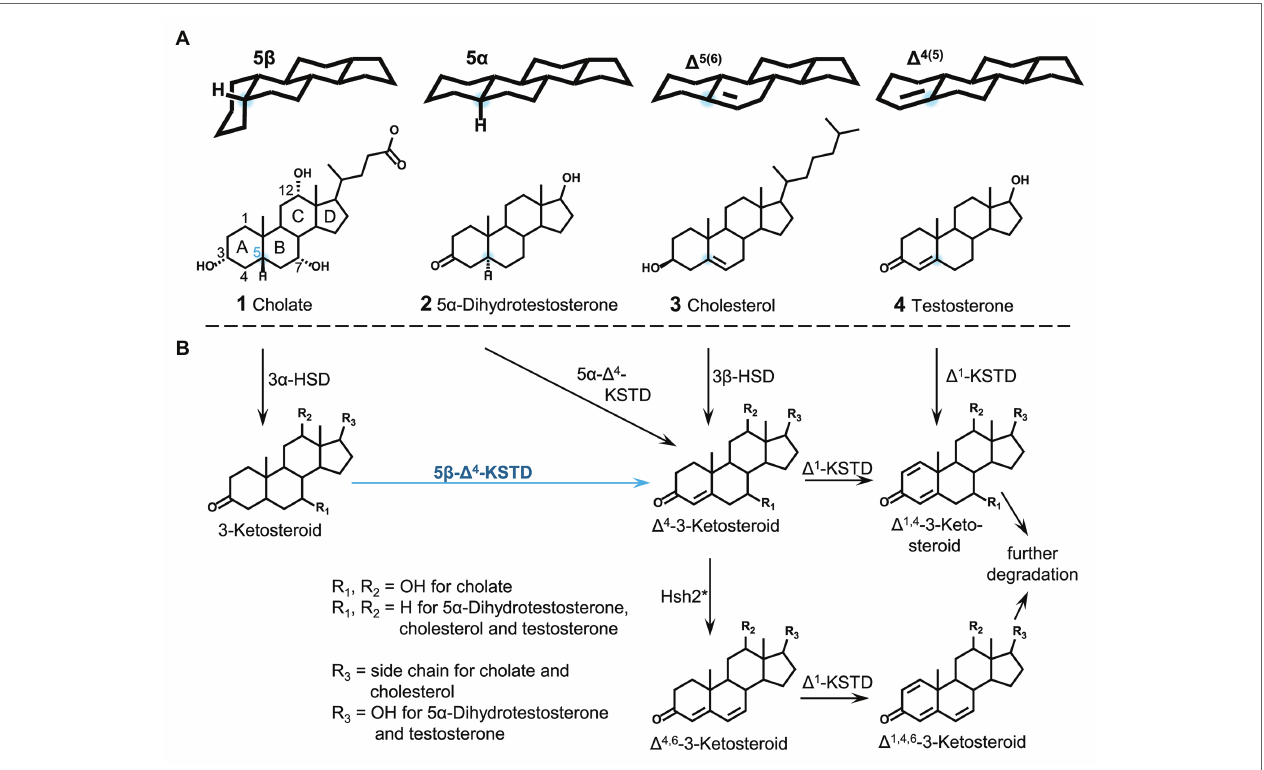
FIGURE 1 | Conformation and structures of steroids from different functional classes with varying stereochemistry at C5 (A) and first steps of bacterial steroid degradation, namely A-ring oxidation to canonical Δ 1,4 -3-ketosteroids (B) . HSD, Hydroxysteroid dehydrogenase; KSTD, 3-ketosteroid dehydrogenase; Hsh2, hydroxysteroid dehydratase of Sphingobium sp. strain Chol11. Blue dots: C5. *This reaction only takes place for 7-hydroxysteroids and in specialized organisms such as Sphingobium sp. strain